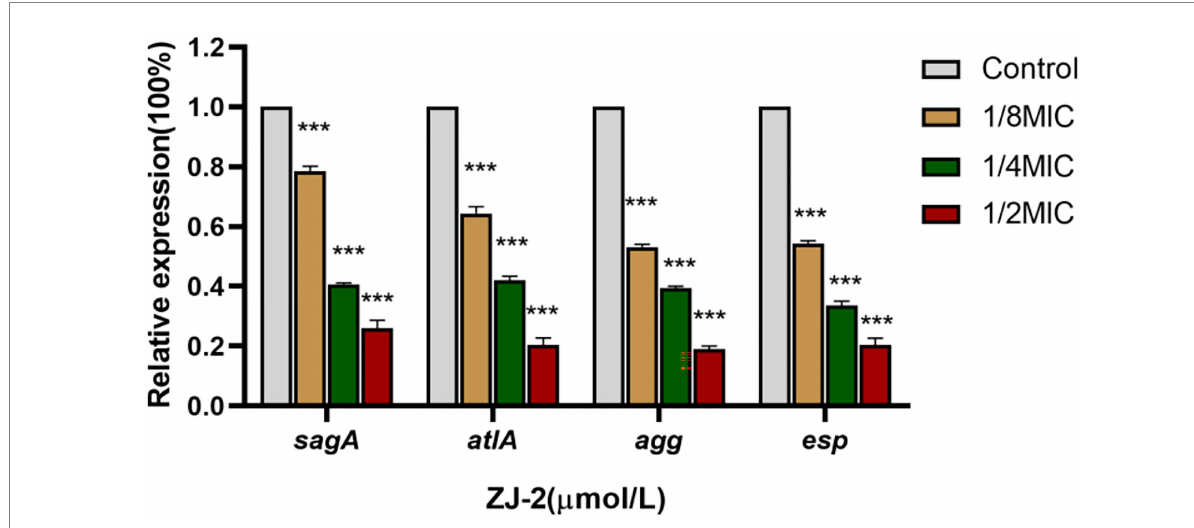
FIGURE 7 ZJ-2 decreased the expression of the sagA and atlA genes and adherence-related genes agg and esp in E3101 (*** p < 0.01).